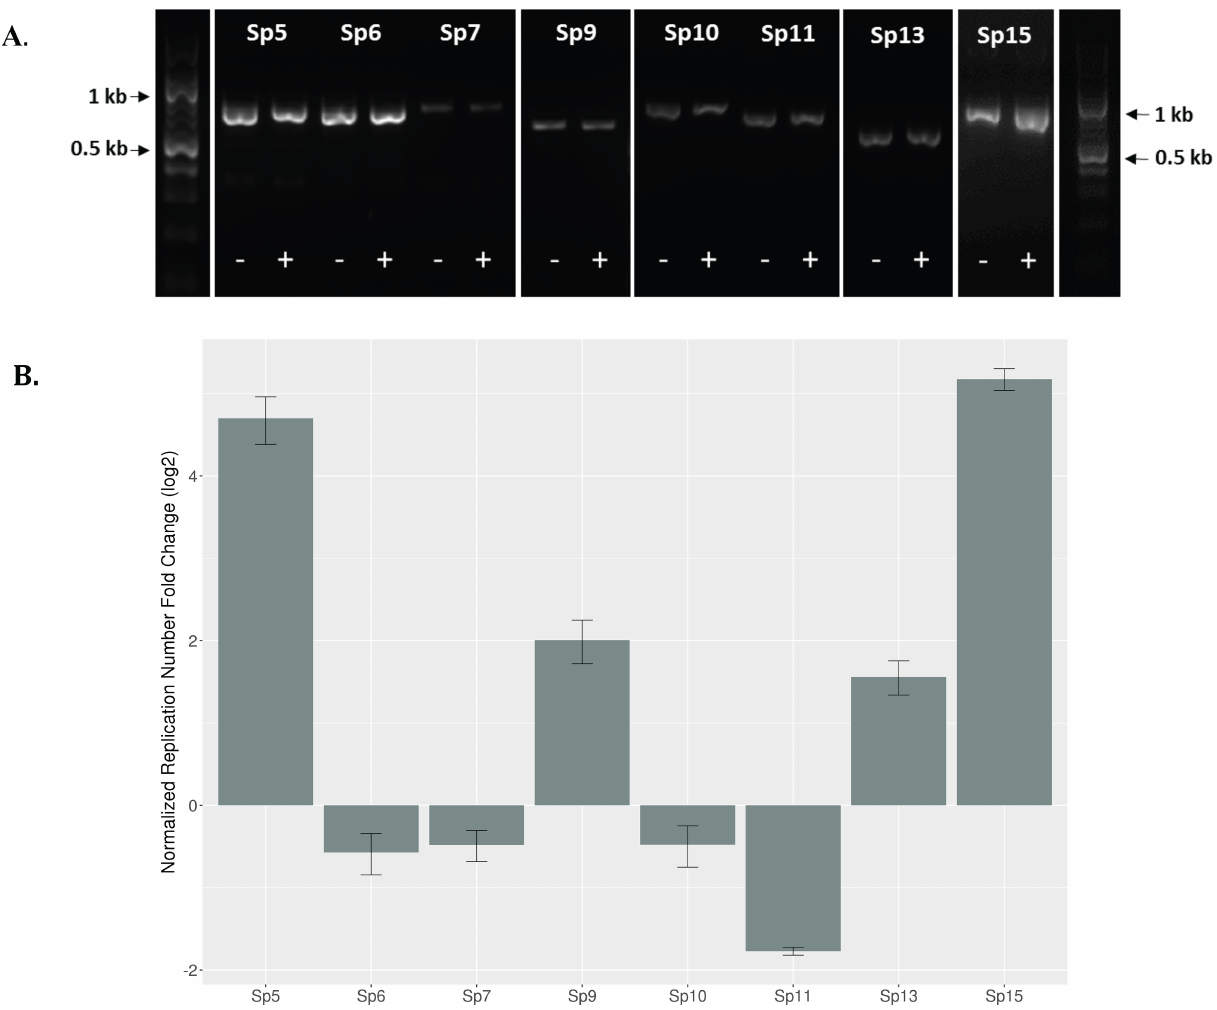
Fig 1. SMX-TM induced excision and fold-change estimates of PA20 Sp regions. (A) PCR amplification of the attachment site of excised and circularized Sp regions from PA20 grown on T-agar plates without (-) and with (+) an antibiotic cocktail at concentration of 27x (540 μg/L SMX and 108 μ g/L TM). Sp regions 1, 2, 3, 4, 8, 12, 14, 16, 17 and SpLE4 (LEE) that did not prime amplification are not shown. Mu-like prophage of region Sp18 and SpLE except for SpLE4 were not tested. (B) Log 2 FC copy-number differences between SMX-TM-induced and untreated (spontaneously induced) forms of the different excised and circularized PA20 SP regions. qRT-PCR was performed on DNA derived from three independent samples of PA20 grown on T-agar containing 540 μg/L SMX and 108 μg/L TM (27x), and analyzed using the 2 - ΔΔ CT method [60].